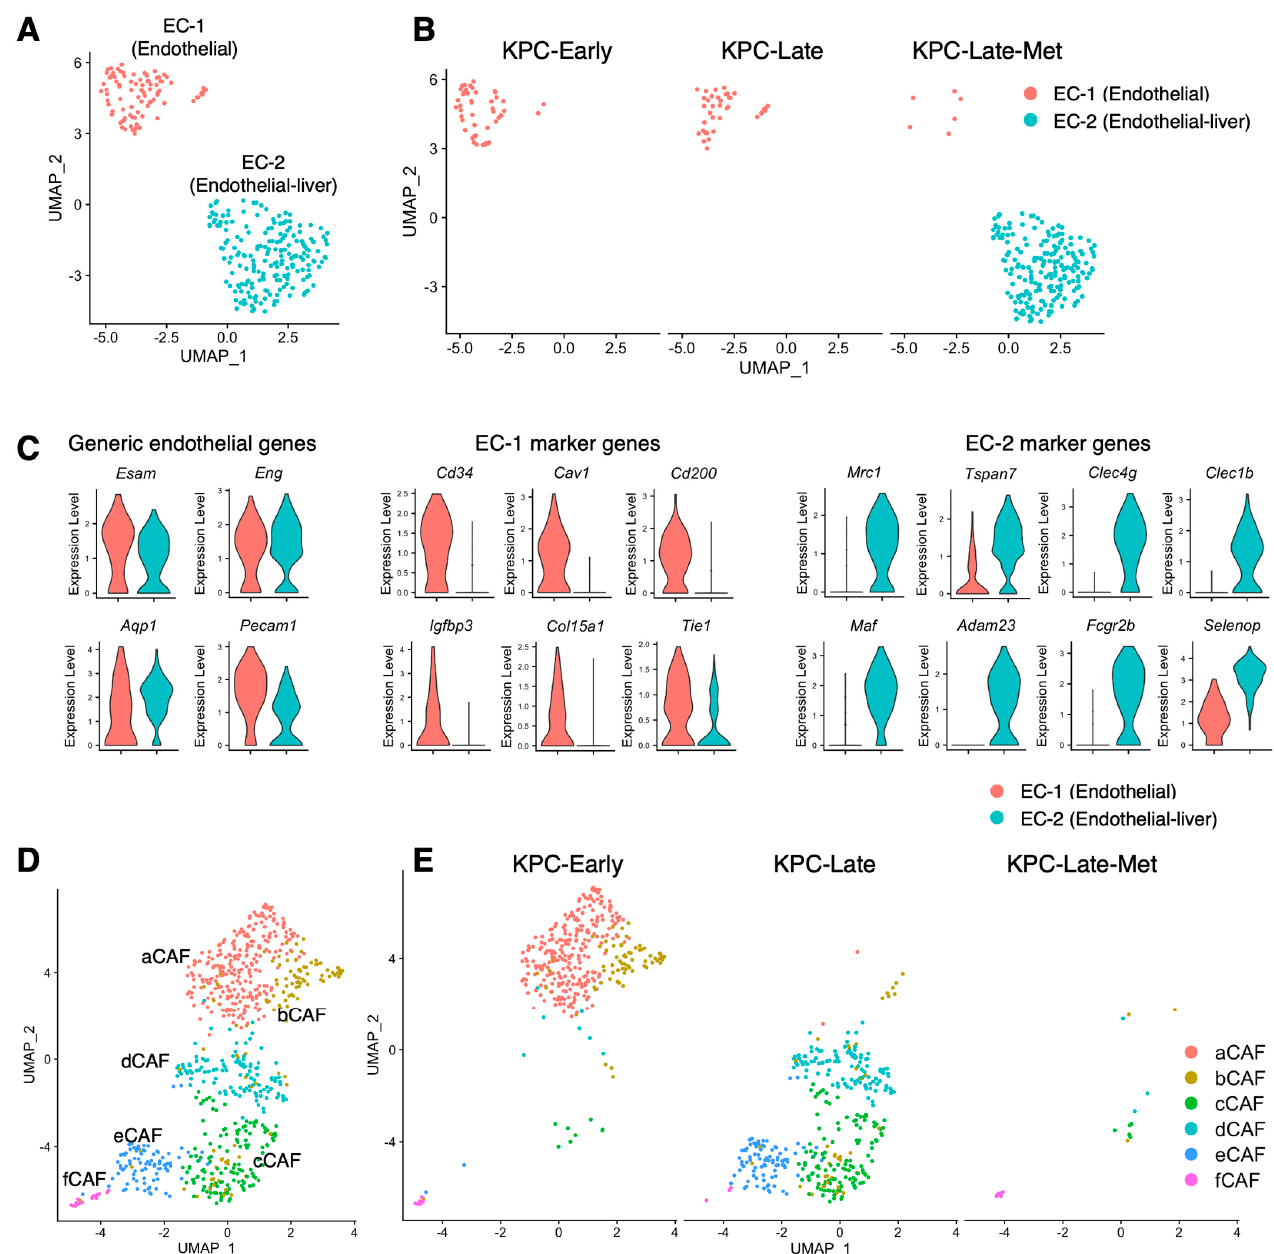
Figure 5. Cell compositions of subclusters of endothelial cells and fibroblasts in primary tumors and liver metastases. ( A – C ) Endothelial cells from primary tumors and liver metastases are characterized in UMAP plot ( A ) and compared across KPC-Early, KPC-Late, and KPC-Late-Met groups ( B ). The signature genes of endothelial cells from primary tumors or endothelial cells from liver metastases are shown in violin plot ( C ). ( D , E ) Various subpopulations of cancer-associated fibroblasts (CAFs) from primary tumors and liver metastases are characterized in UMAP plot ( D ) and compared across KPC-Early, KPC-Late, and KPC-Late-Met groups ©.